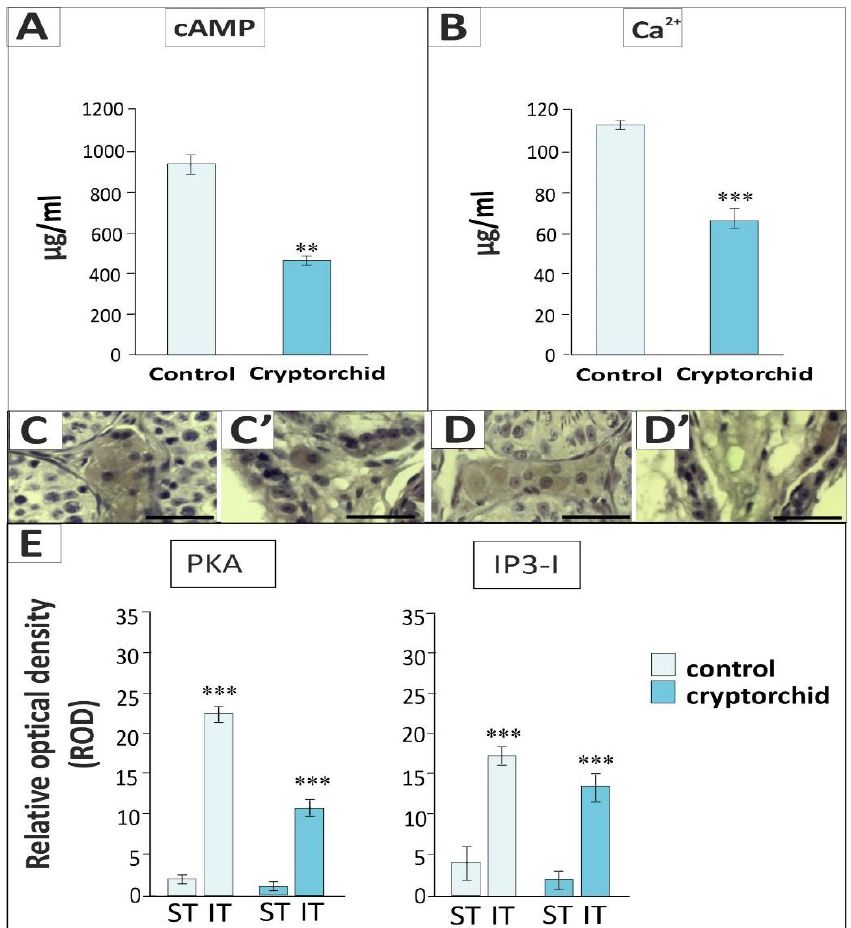
Figure 3. Upper panel: cAMP ( A ) and Ca2+ ( B ) levels; lower panel: representative microphotographs of immunohistochemical localization of PKA ( C , C’ ), IP3 I ( D , D’ ), and quantitative analysis of PKA or IP3 I immunosignals in the seminiferous tubules (ST) and interstitial tissues (IT) ( E ) of healthy (control) and cryptorchid horse testes. Data are expressed as means ± S.D. Significant differences between healthy and cryptorchid testes are denoted as ** p < 0.01 and *** p < 0.001. Analyses were performed in triplicate.